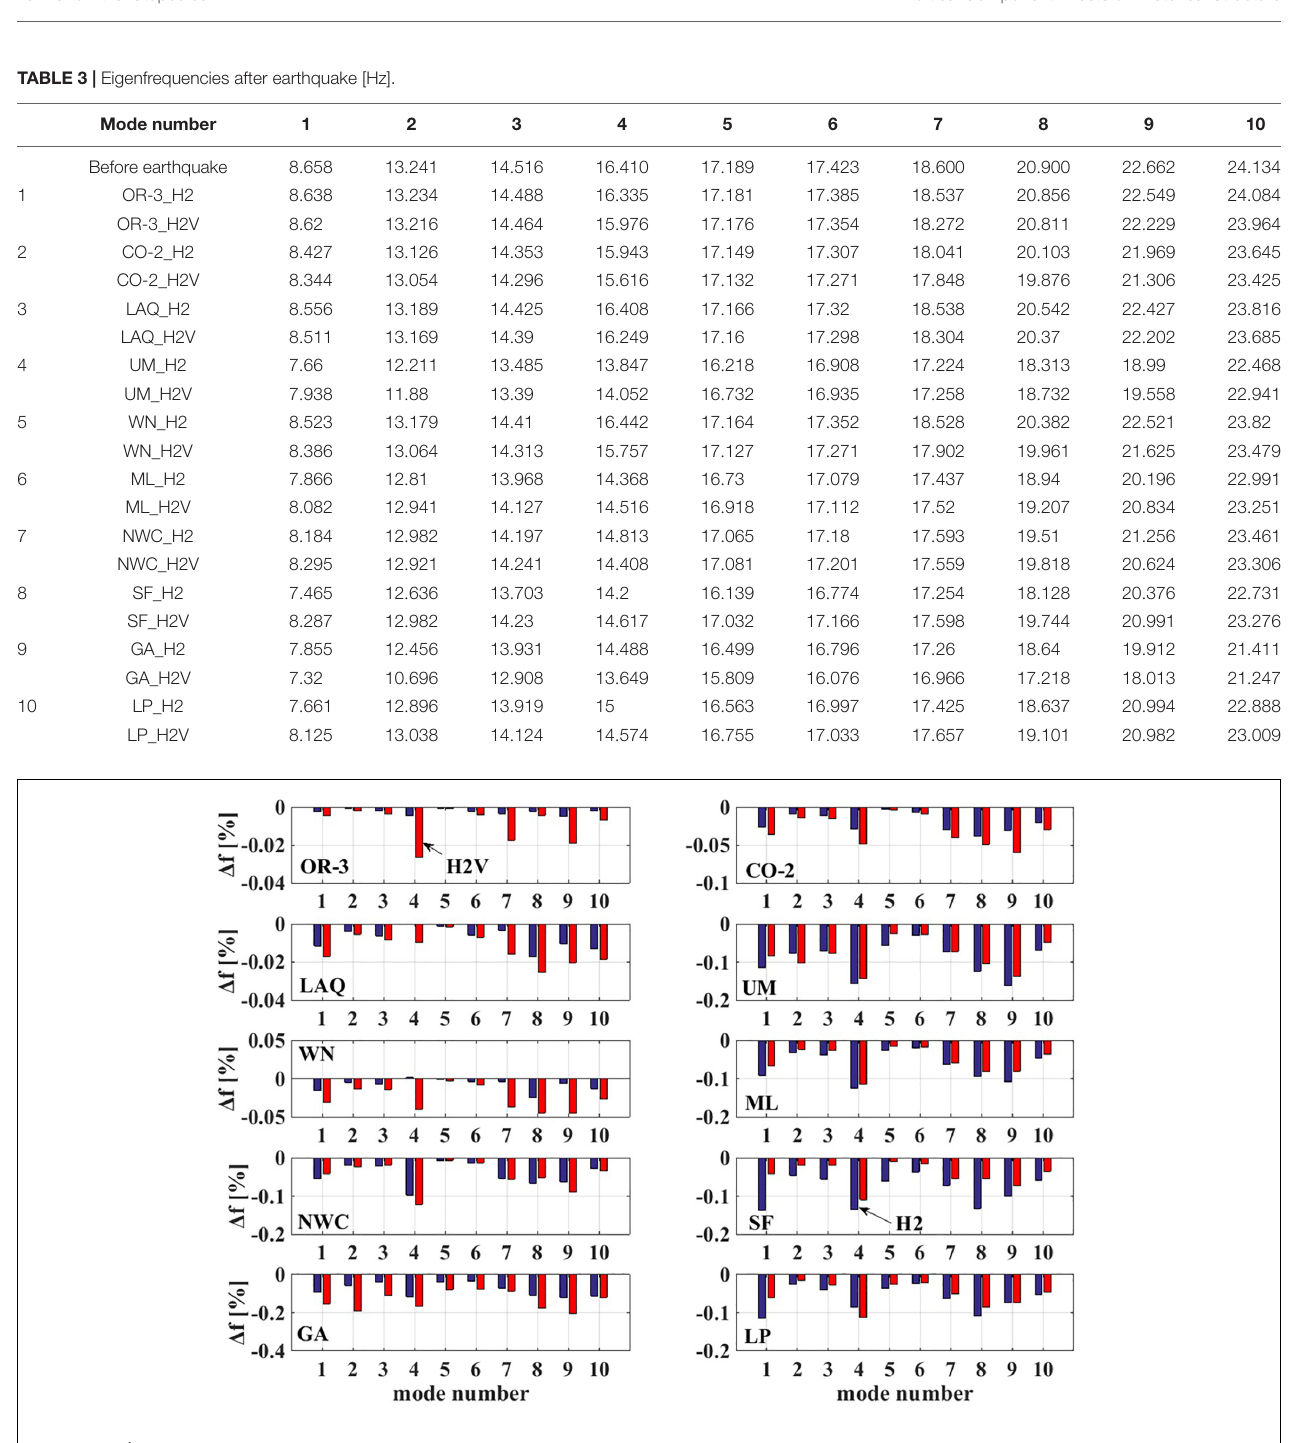
FIGURE 12 | Variation of eigenfrequencies according to before earthquake condition.